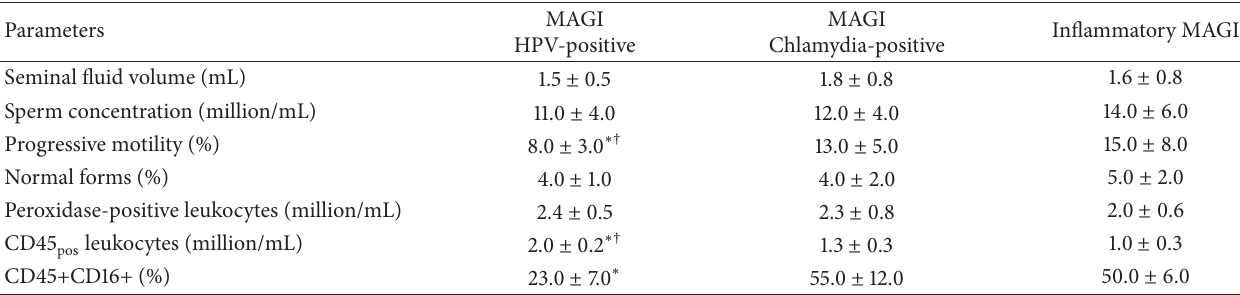
Table 2: Sperm parameters and seminal fluid leucocyte concentration measured by flow cytometry in the three groups of patients with male accessory gland infection/inflammation (MAGI) enrolled in this